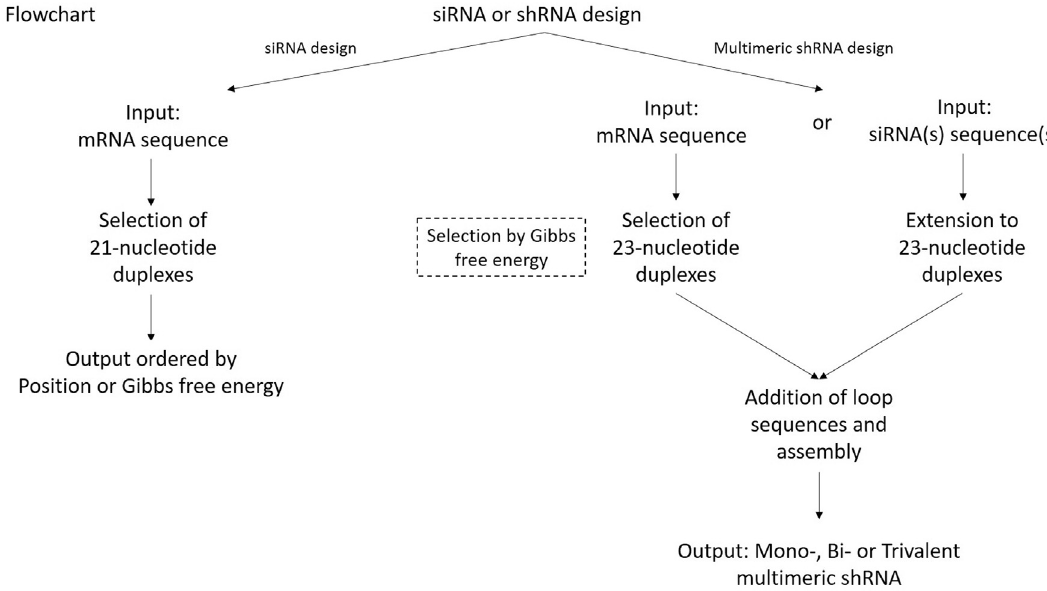
Figure 1 - si- and shRNA (SSD) flowchart. SSD software is suitable for designing both siRNAs and multimeric shRNAs. For siRNA design, a target